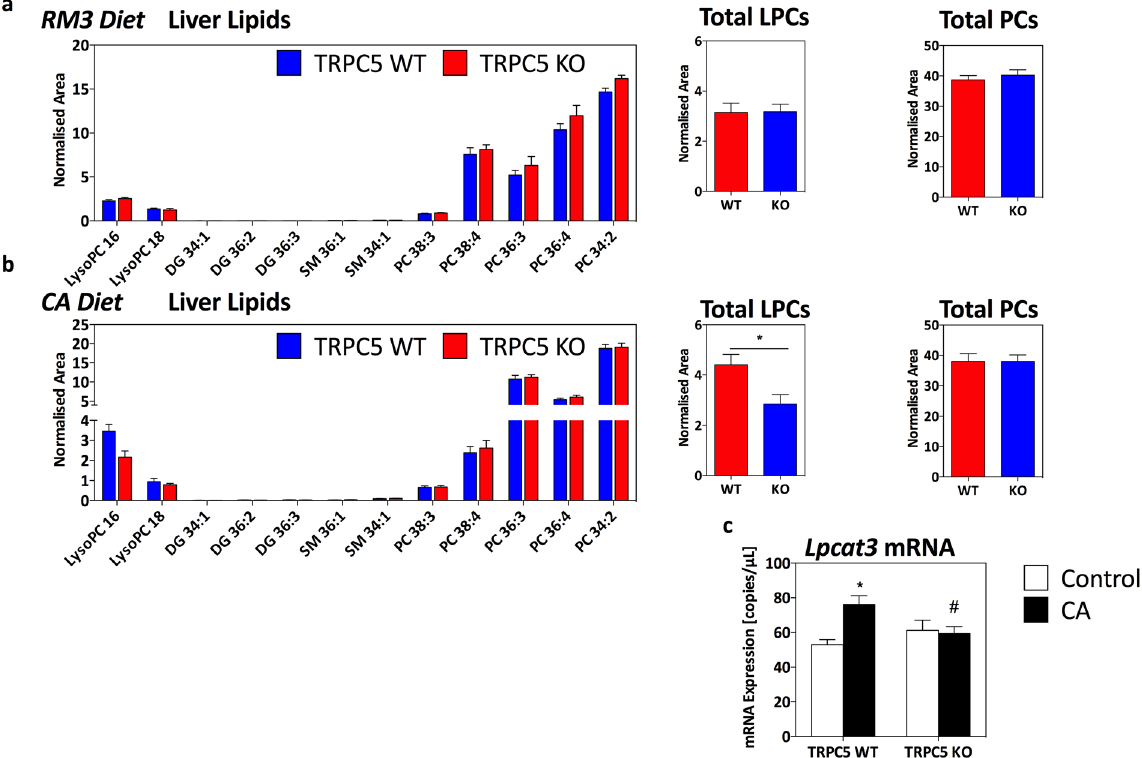
Figure 4. Hepatic lipid profile following CA-induced cholestasis. ( a ) Phospholipid species in WT and TRPC5 KO mice fed control (RM3) diet and ( b ), CA (0.5% cholic acid supplemented RM3 diet) for 21 days with respective total lysophosphatidylcholine and phosphatylcholine species (normalized area). ( c ) Hepatic gene expression determined by real-time quantitative PCR of lysophospholid acyltransferase 3 (Lpcat3) normalized to HPRT, β -actin, and B 2 M. Results are mean ± S.E.M., n = 6–7. * P < 0.05, *** P < 0.001 vs control as determined by two-way ANOVA and Bonferronni Post Hoc